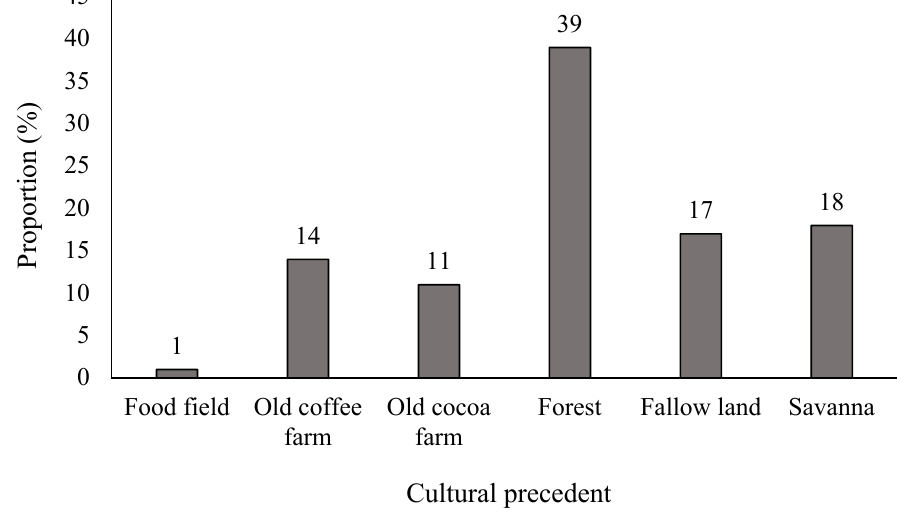
Figure 12. Cultivation history of cocoa farms in Biankouma region.